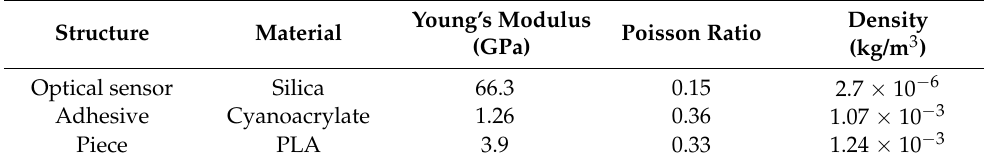
Table 1. Material properties used in the theoretical static